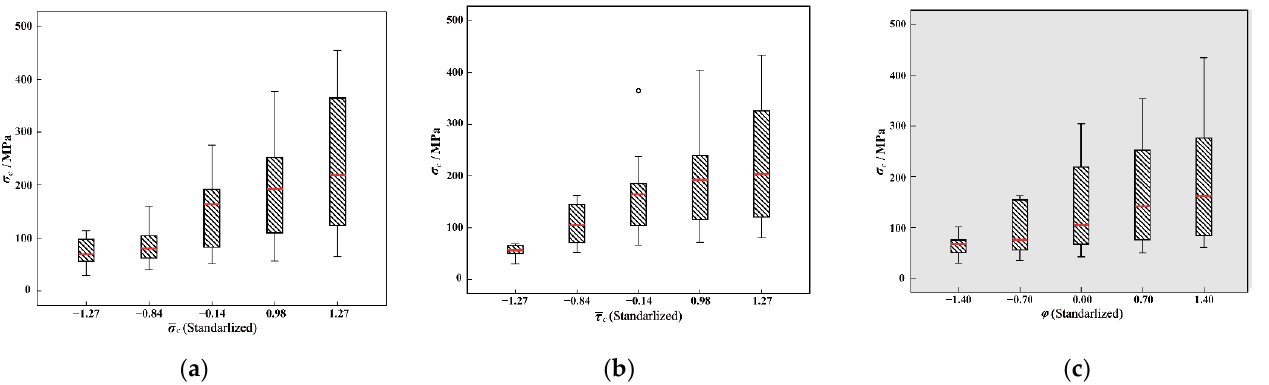
Figure 10. Boxplot between peak strength and meso parameters: ( a ) Tensile strength of parallel bond; ( b ) Shear strength of parallel bond; ( c ) Internal friction angle.